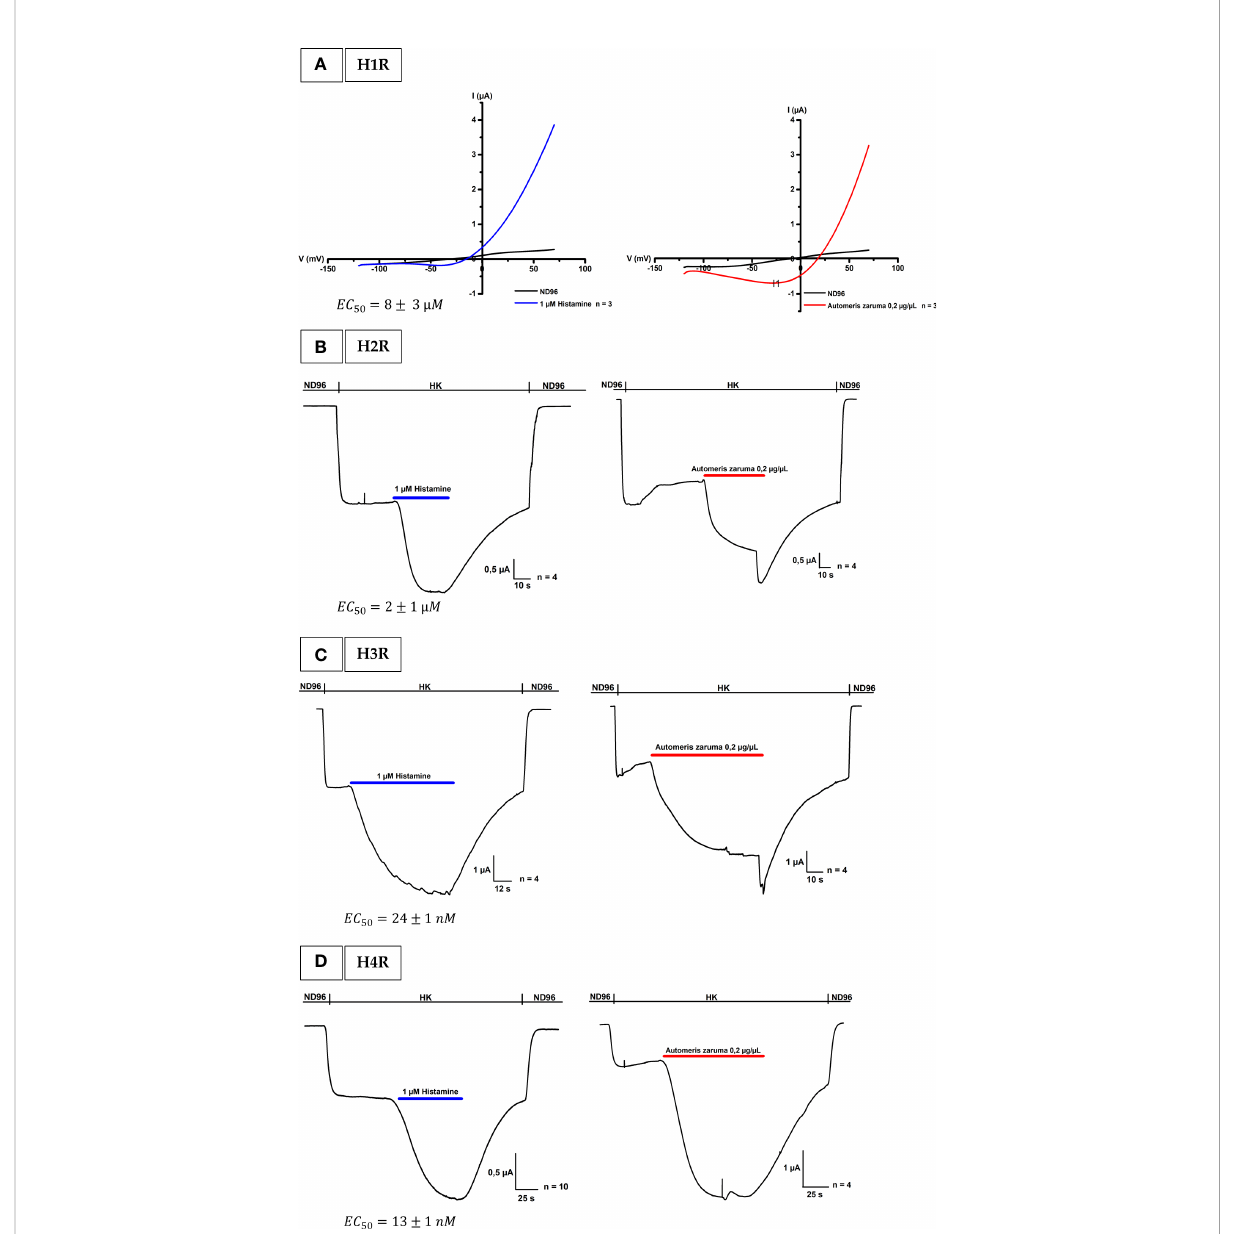
FIGURE 2 Activation of histamine receptors by A. zaruma venom extract in Xenopus oocytes. (A) A representative current trace of H1R. A change in conductance is observed upon application of 1 µM histamine (blue, left) and 0.2 µg/µL venom extract (red, right). (B) A representative current trace of H2R shows a current increase upon application of 1 m M histamine (blue, left) and in the presence of A. zaruma venom extract (red, right). (C) A representative current trace of H3R. Current enhancement is observed upon application of 1 m M histamine (blue, left) and in the presence of A. zaruma venom extract (red, right). (D) validation trace experiments of H4R, currents were induced upon application of 1 m M histamine (blue, left) and in the presence of A. zaruma venom extract (red,